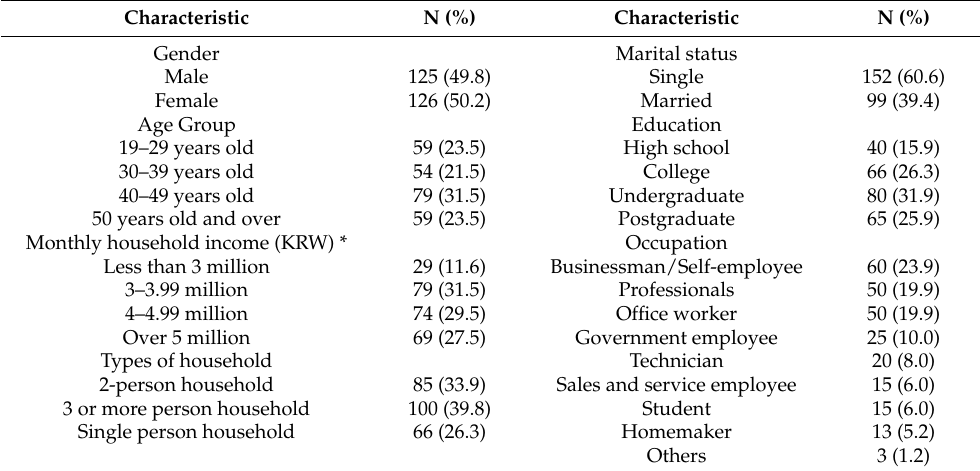
Table 1. Demographic characteristics of the